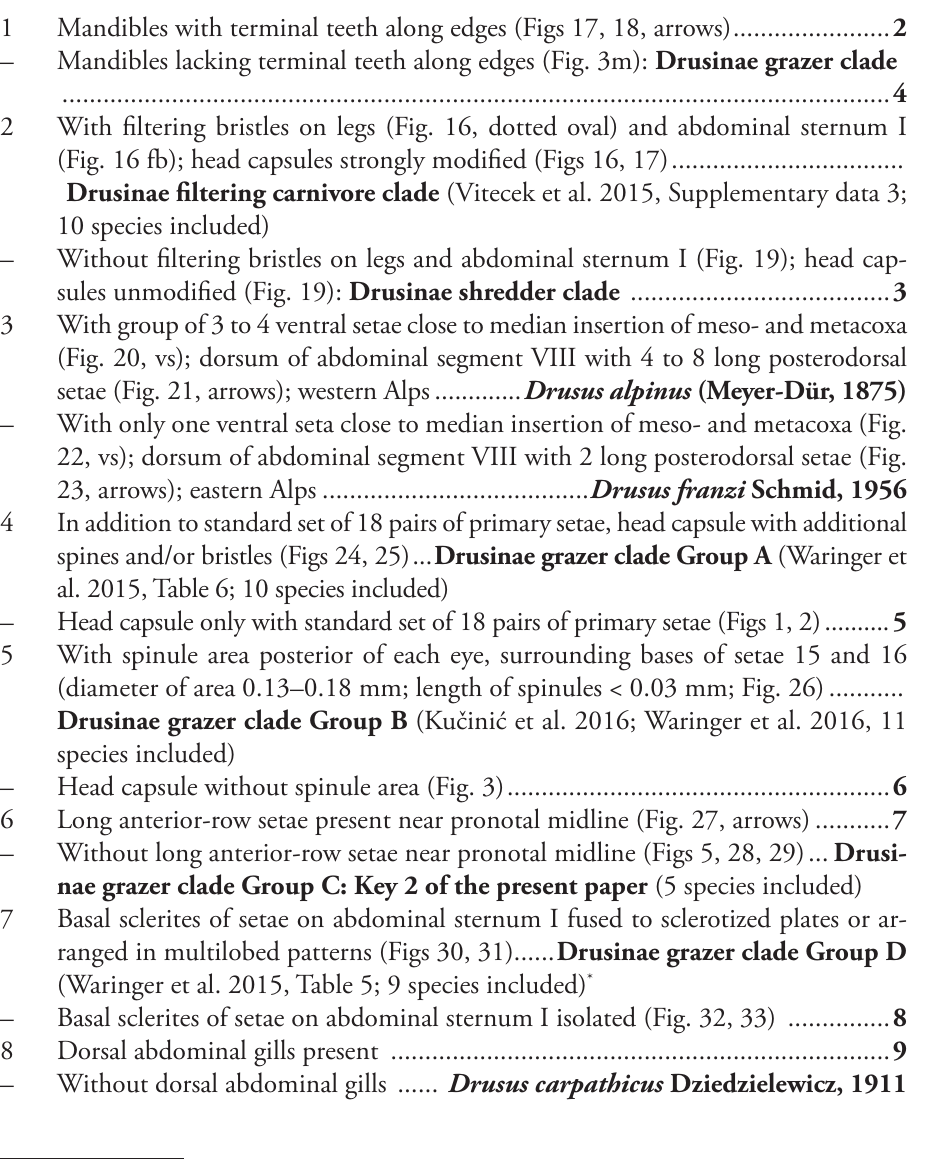
Key 1: Master key for main groups of larval Drusinae (final instars) 1 Mandibles with terminal teeth along edges (Figs 17, 18, arrows) ....................... 2 – Mandibles lacking terminal teeth along edges (Fig. 3m): Drusinae grazer clade ......................................................................................................................... 4 2 With filtering bristles on legs (Fig. 16, dotted oval) and abdominal sternum I (Fig. 16 fb); head capsules strongly modified (Figs 16, 17) .................................. Drusinae filtering carnivore clade (Vitecek et al. 2015, Supplementary data 3; 10 species included) – Without filtering bristles on legs and abdominal sternum I (Fig. 19); head cap- sules unmodified (Fig. 19): Drusinae shredder clade ...................................... 3 3 With group of 3 to 4 ventral setae close to median insertion of meso- and metacoxa (Fig. 20, vs); dorsum of abdominal segment VIII with 4 to 8 long posterodorsal setae (Fig. 21, arrows); western Alps ............. Drusus alpinus (Meyer-Dür, 1875) With only one ventral seta close to median insertion of meso- and metacoxa (Fig. 22, vs); dorsum of abdominal segment VIII with 2 long posterodorsal setae (Fig. 23, arrows); eastern Alps ....................................... Drusus franzi Schmid, 1956 4 In addition to standard set of 18 pairs of primary setae, head capsule with additional spines and/or bristles (Figs 24, 25) ... Drusinae grazer clade Group A (Waringer et al. 2015, Table 6; 10 species included) – Head capsule only with standard set of 18 pairs of primary setae (Figs 1, 2) .......... 5 5 With spinule area posterior of each eye, surrounding bases of setae 15 and 16 (diameter of area 0.13–0.18 mm; length of spinules < 0.03 mm; Fig. 26) ........... Drusinae grazer clade Group B (Kučinić et al. 2016; Waringer et al. 2016, 11 species included) – Head capsule without spinule area (Fig. 3) ........................................................ 6 Long anterior-row setae present near pronotal midline (Fig. 27, arrows) ........... 7 – Without long anterior-row setae near pronotal midline (Figs 5, 28, 29) ... Drusi- nae grazer clade Group C: Key 2 of the present paper (5 species included) 7 Basal sclerites of setae on abdominal sternum I fused to sclerotized plates or ar- ranged in multilobed patterns (Figs 30, 31)...... Drusinae grazer clade Group D (Waringer et al. 2015, Table 5; 9 species included)